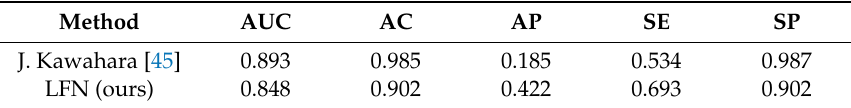
Table 9. Dermoscopic feature extraction performances of different